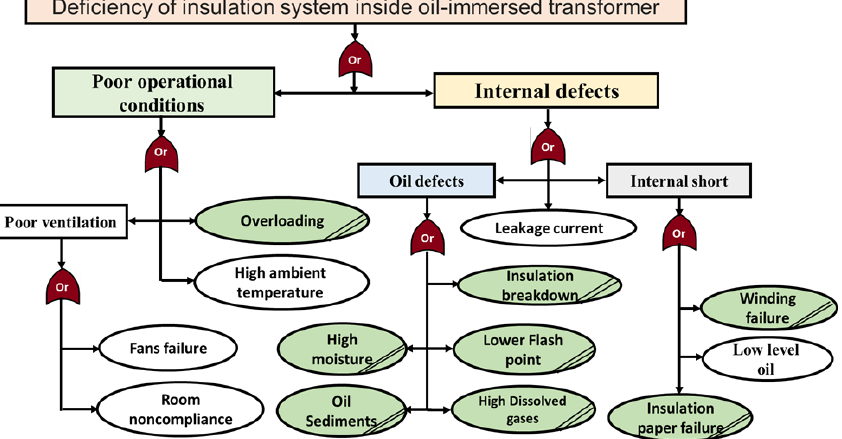
Figure 5. Fault-tree analysis of the deficiency of insulation system inside oil-immersed DTs.